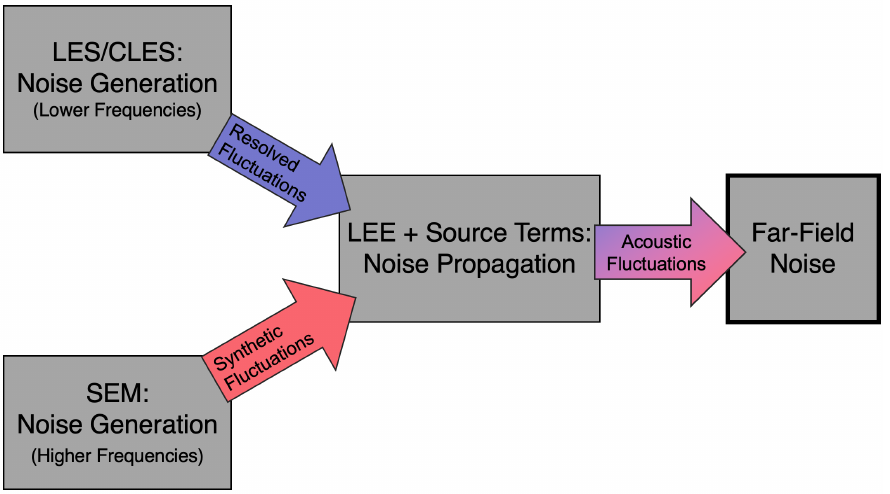
Figure 2. Diagram of the CLST